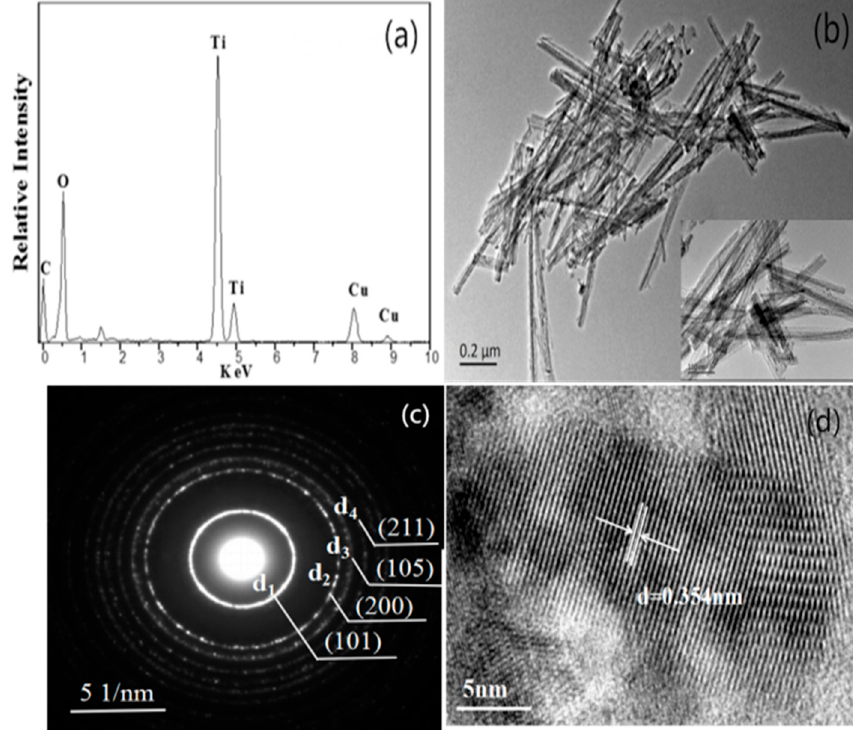
Figure 7. Characterization of TiO 2 nanotubes. ( a ) energy dispersive X-ray (EDX) spectra of TiO 2 nanotubes. ( b ) Transmission electron microscope (TEM) image of TiO 2 nanotubes. ( c ) Electron diffraction pattern of the TiO 2 nanotubes. ( d ) High-resolution transmission electron microscope (HRTEM) image of the TiO 2 nanotubes.